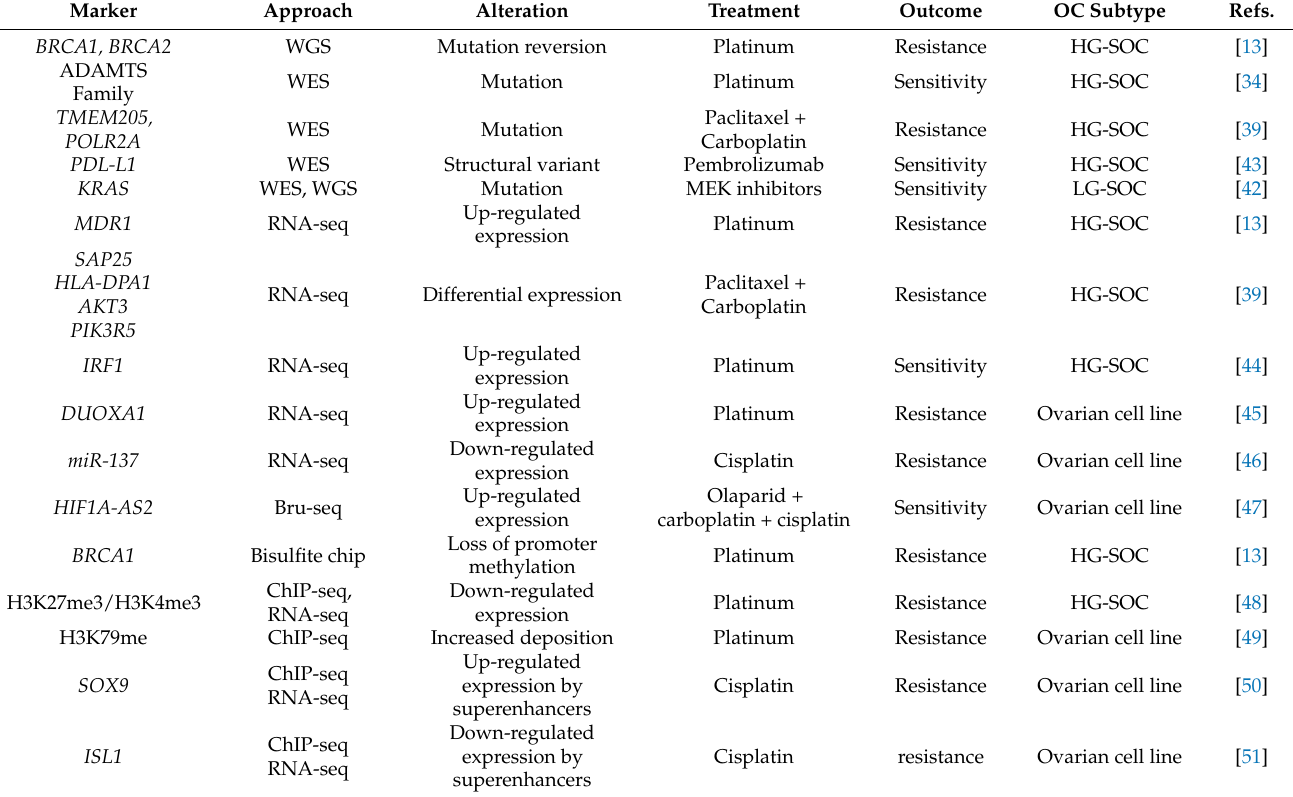
Table 2. Markers of OC chemoresistance identified by genomic, transcriptomic, and epigenomic techniques. Marker Approach Alteration